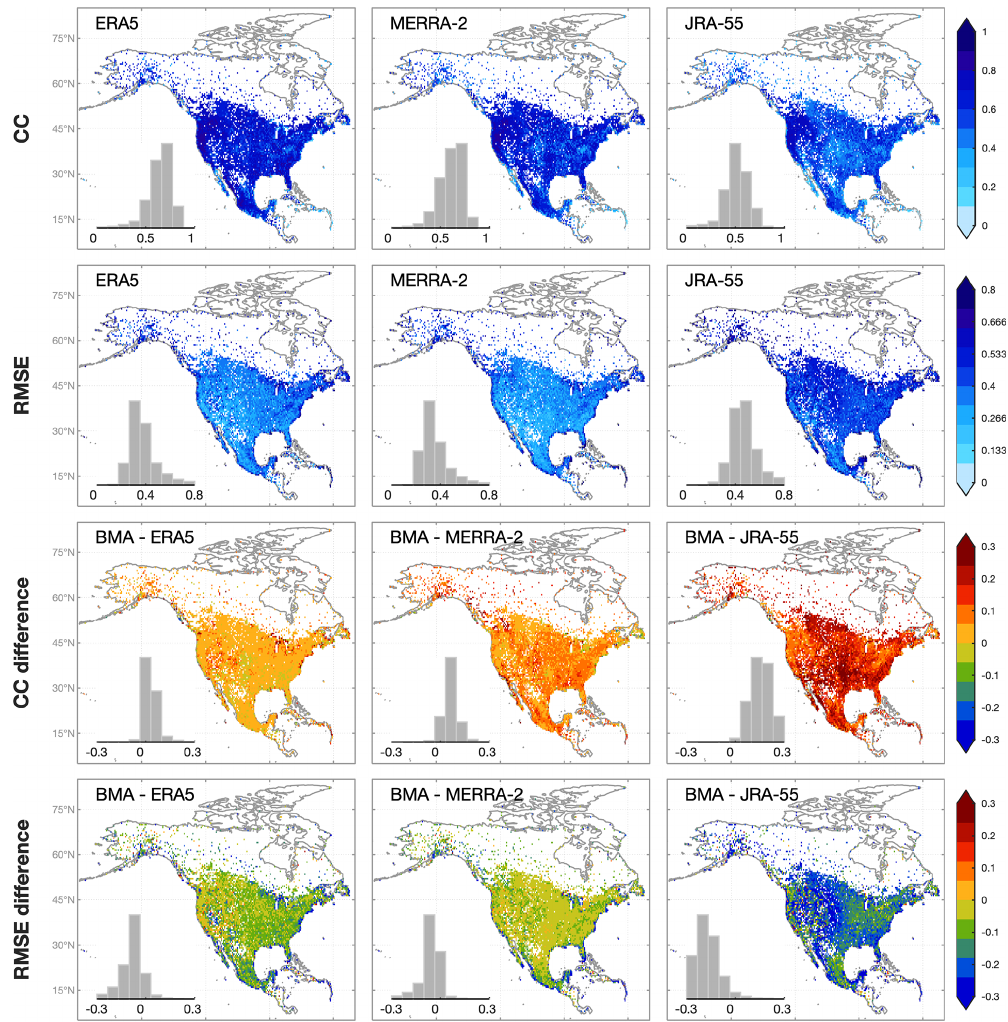
Figure 5. Same as Fig. 3 but for daily temperature